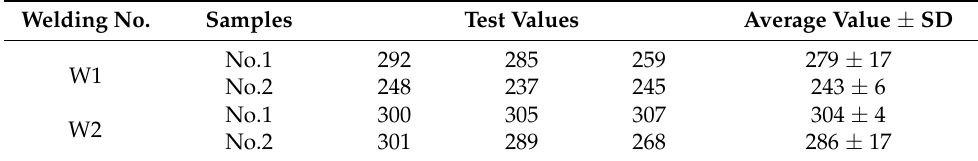
Table 7. HAZ impact toughness for the steels after subjecting to submerged arc welding. Welding No.